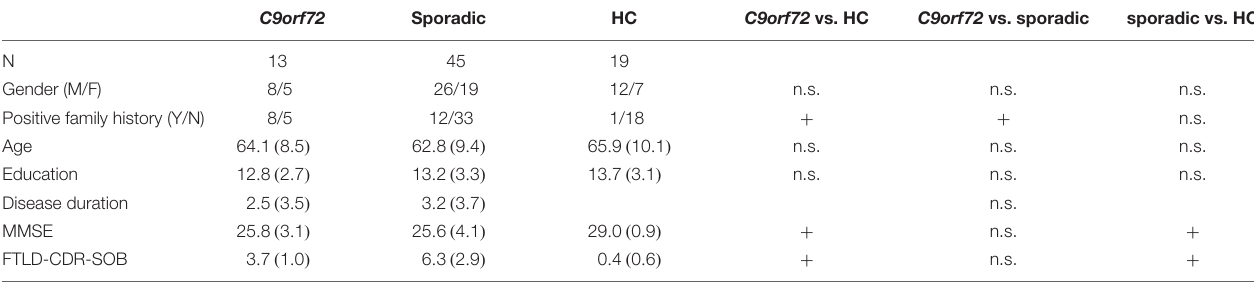
TABLE 1 | Demographics and neuropsychological measures of the study sample. C9orf72 Sporadic C9orf72 vs. HC C9orf72 vs. sporadic